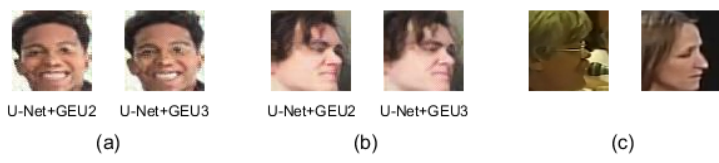
Figure 12. Examples of low face feature extraction performance. ( a , b ) U-Net + GEU2 (passed) and U-Net + GEU3 (failed) methods comparison. ( c ) Examples of profile face images of database samples that passed face features extraction as well during the database creation filtration